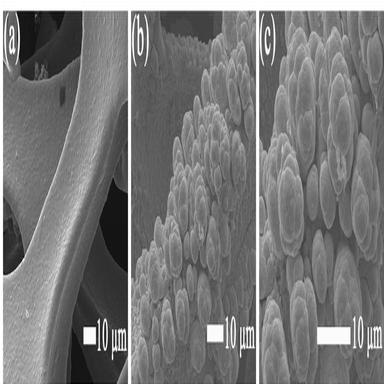
FESEM images of (a) bare Ni foam, (b) CdSe (40 min), and (c) magnified CdSe.